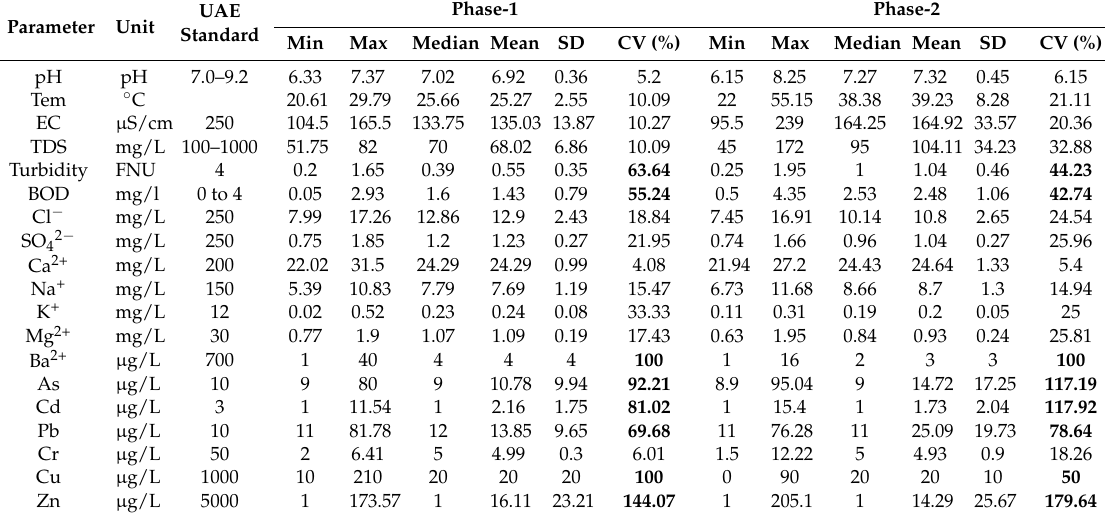
Table 1. Descriptive statistics of physicochemical parameters and heavy metals for 30 households in